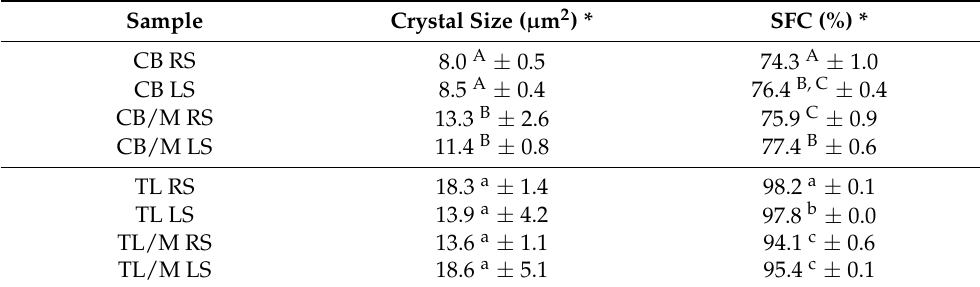
Table 1. Crystal size and solid fat content (SFC) measurements for cocoa butter (CB) and trilaurin (TL)